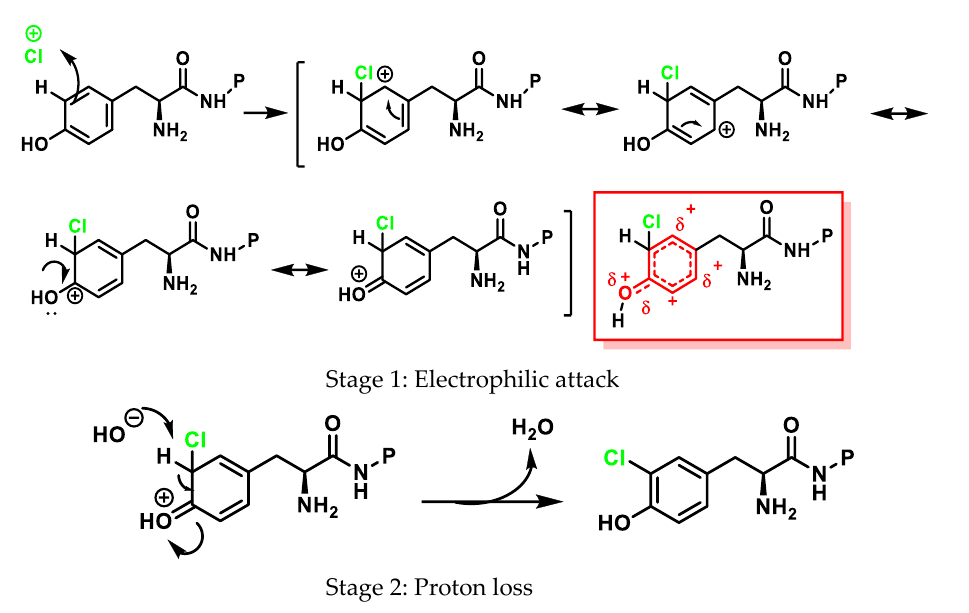
Figure 24. Mechanism of the electrophilic substitution in tyrosine and the formation of 3-chlorotyro- sine. Stage 1: electrophilic attack; Stage 2: proton loss. Stage 1: electrophilic attack; Stage 2: proton loss.